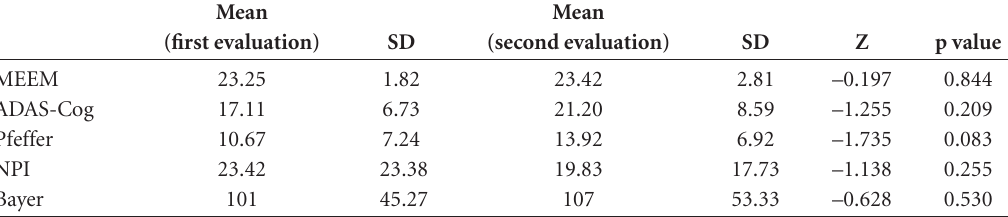
Table 2. Comparisons between first and second scores on cognitive, behavior, and functional